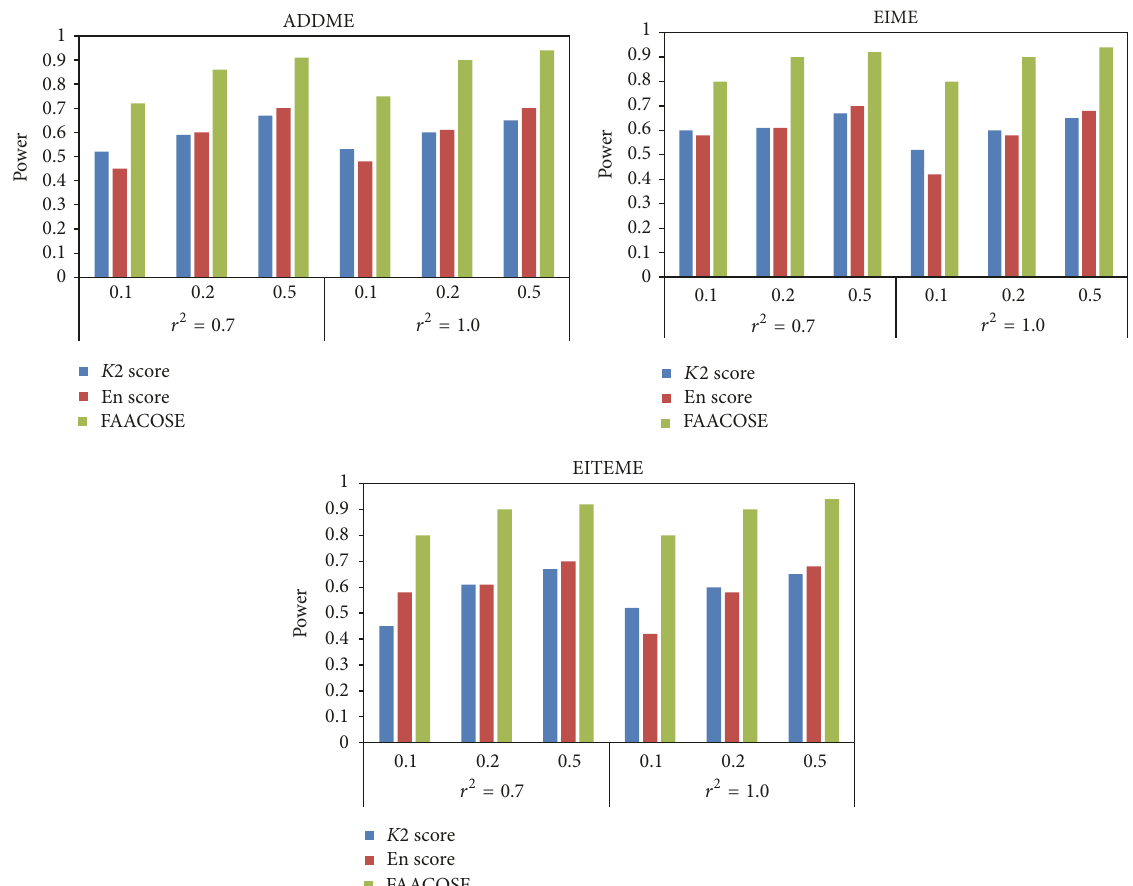
Figure 2: Power test comparisons between one-objective and two-objective methods on three different model with MAF value 0.1, 0.2, and